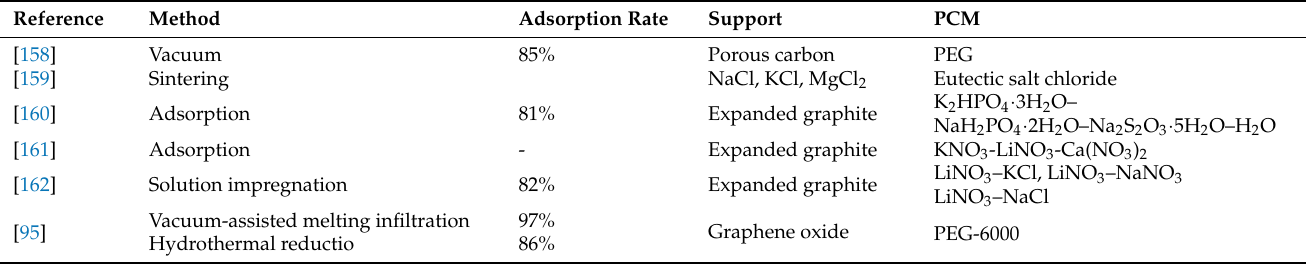
Table 4. PCM impregnation into the support material. Methods and